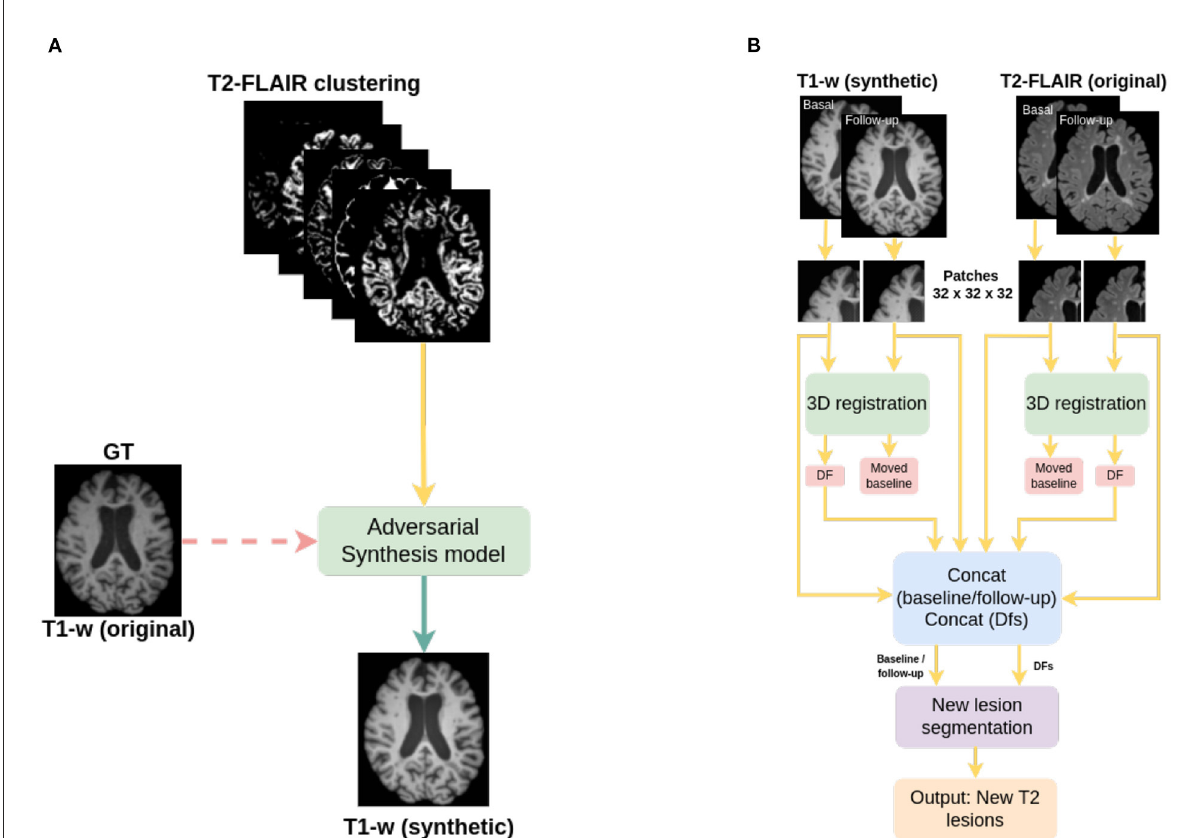
FIGURE1 Pipelines used in this work; (A) pipeline for the synthesis of T1-w images, and (B) pipeline for new T2-w lesion detection in longitudinal analysis. The dashed line in (A) indicates that original T1-w images are used only in the training of the synthesizer.